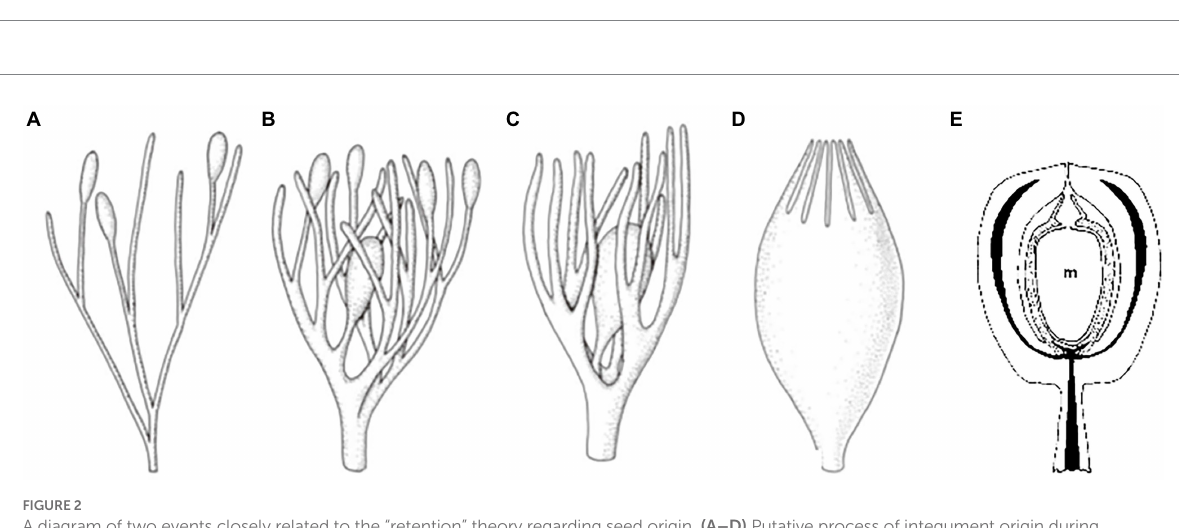
FIGURE 2 A diagram of two events closely related to the “retention” theory regarding seed origin. (A–D) Putative process of integument origin during evolution according to the “telome theory.” (A) Oval-shaped megasporangia are located at the tips of the telomes/branches. (B,C) Several telomes/branches were coopted as surrounding tissues to enclose the dominant/fertile megasporangium. (D) The surrounding tissues merged into a structure designated as the integument (often consisting of two layers in angiosperms; modified from Taylor et al., 2009). (E) Illustration of a stalked ovule of Callospermarion . “m” refers to a megaspore in the megasporangium (indicated by the dotted region) enclosed by the integument with vascular bundles represented by the black strips (modified from Herr,